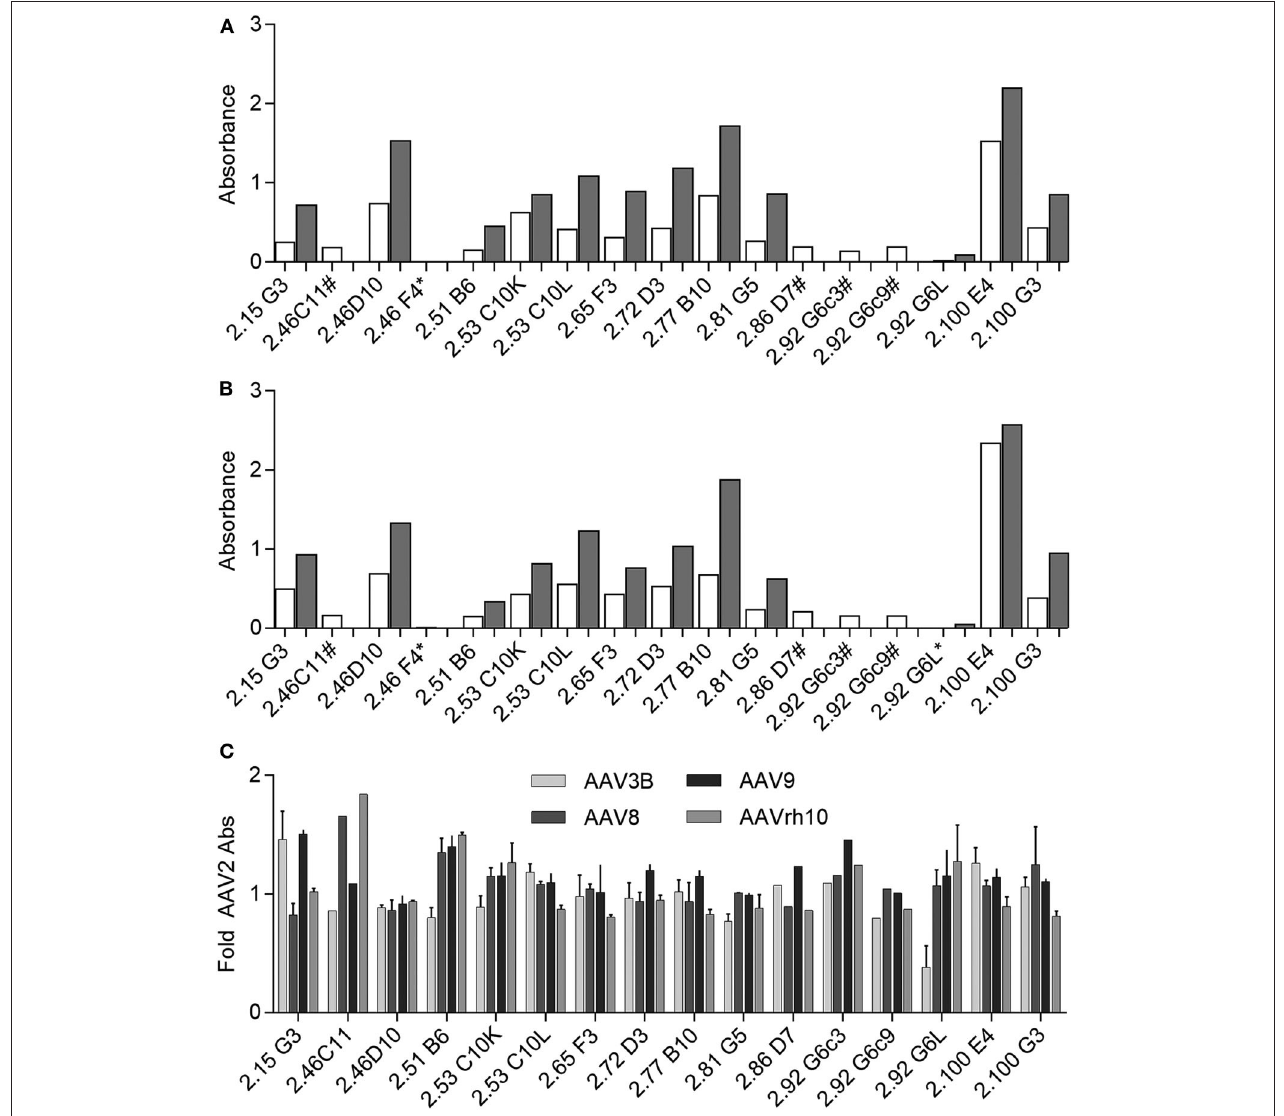
FIGURE 6 | Evaluating human α AAV mAbs for AAV capsid binding. (A,B) Recombinant Donor 7 mAbs were produced and evaluated for (A) AAV2 or (B) AAV3B binding by ELISA. Samples were diluted to 100ng/mL (white bars) or 250ng/mL (gray bars) for evaluation. Some samples could not be produced at sufficient concentration to evaluate at 250ng/mL (#); at either concentration, AAV binding could not be detected for some mAbs (*); n = 1 for each antibody concentration. (C) Recombinant mAbs (100ng/mL or 100ng/mL and 250ng/mL, where applicable) were evaluated for binding to a larger panel of AAV serotypes. Binding relative to AAV2 was determined based on absorbance; n = 2. Data from samples for which 100ng/mL and 250ng/mL concentrations could be evaluated are displayed as mean ±